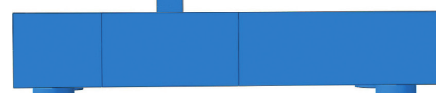
Figure 19: Underpinning beam diagram of MT-1.